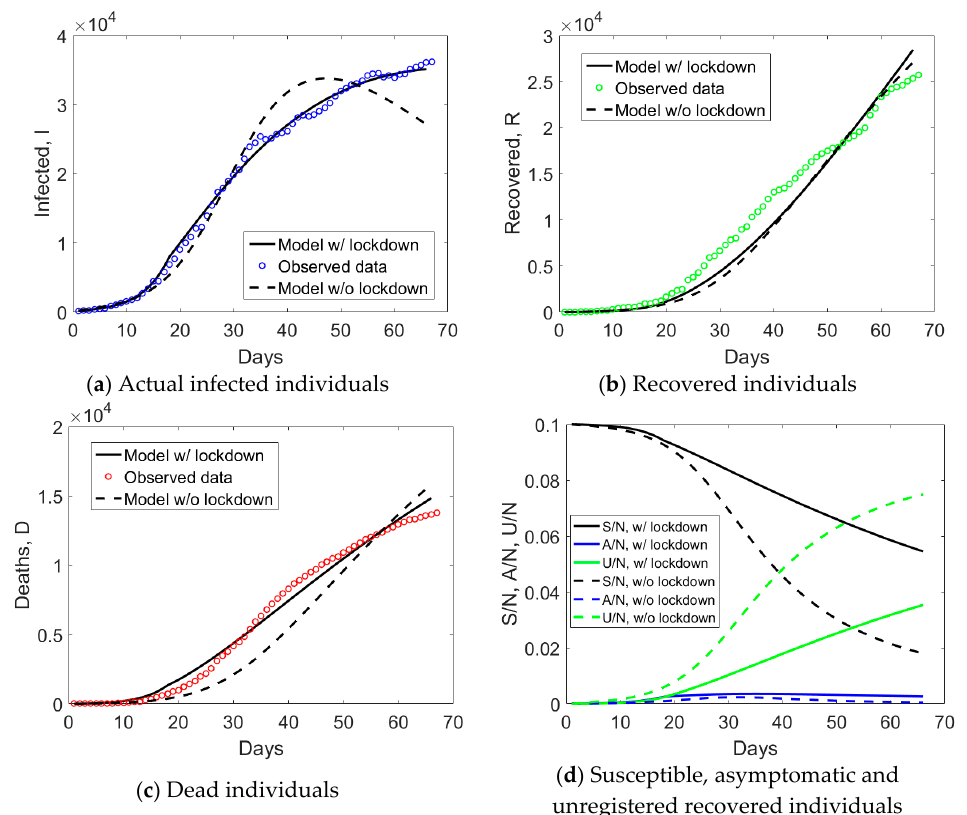
Figure 7. Simulated compartments including or excluding lockdown measures in the model, for Lombardy.